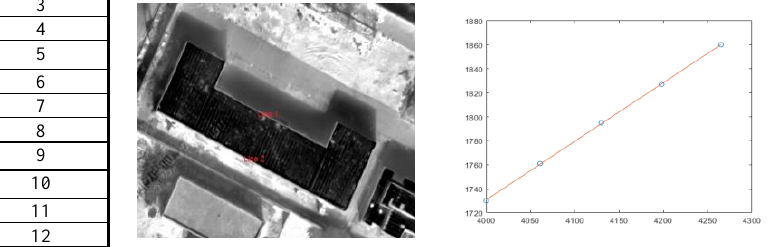
Figure 9. Location of line number 1 (left) and standard deviation chart for line number 1 (right) 77% of the measurements taken from the edges of the buildings coincide with a straight line with an accuracy of better than 2 pixels, and about half of these values are extracted with an accuracy of better than a